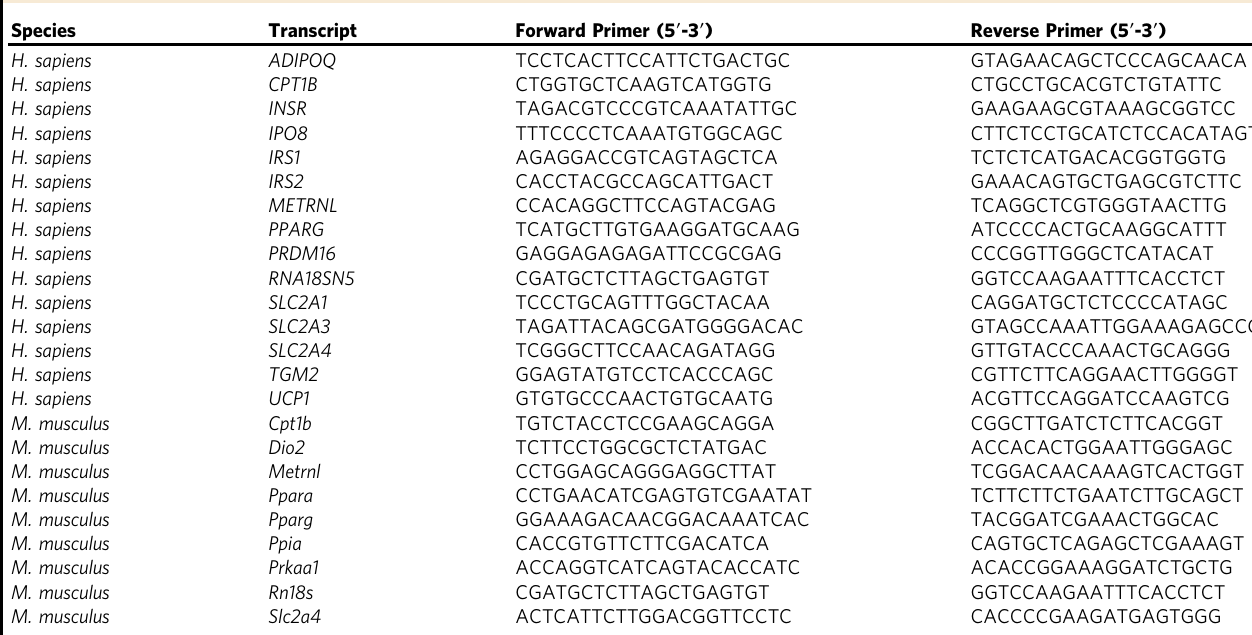
Table 2 Sequences of primers used for